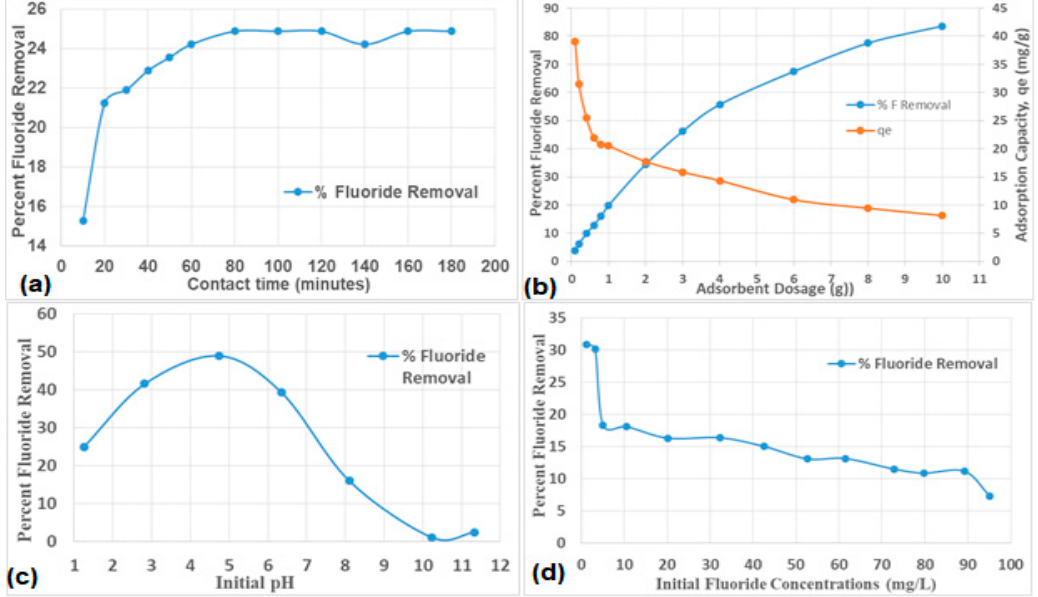
Figure 6. Optimisation of fluoride removal by activated aluminosilicate rich clay soil: ( a ) effect of contact time, ( b ) effect of adsorbent dosage, ( c ) effect of initial pH and ( d ) effect of initial concentration.